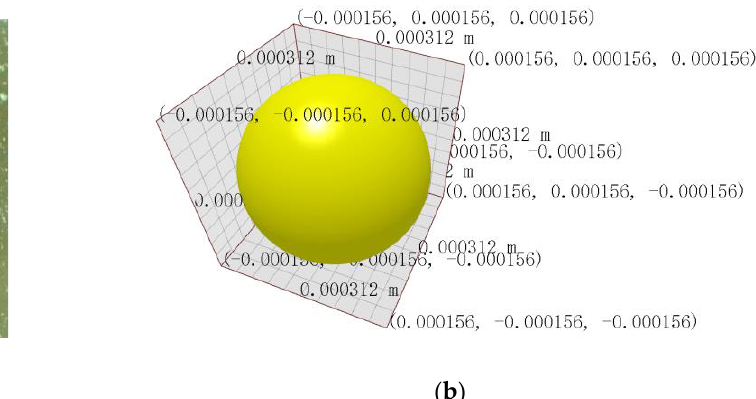
Figure 5. Particle microscope image ( a ) and discrete element particle image ( b ).